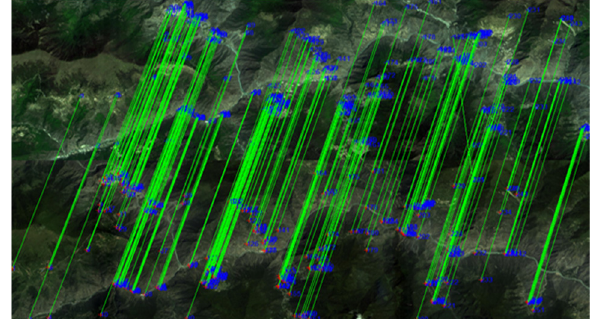
Figure 6. The rough matching result of the GF-1 image pair.